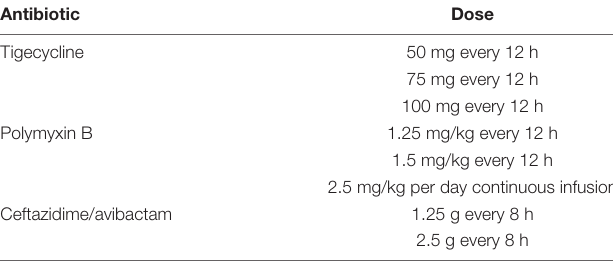
TABLE 1 | Antibiotic regimens used in the Monte Carlo simulations. Antibiotic